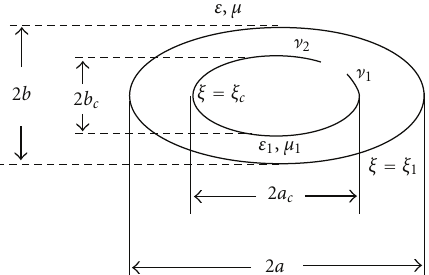
Figure 1: Geometry of an axially slotted antenna on elliptic cylinder coated with dielectric